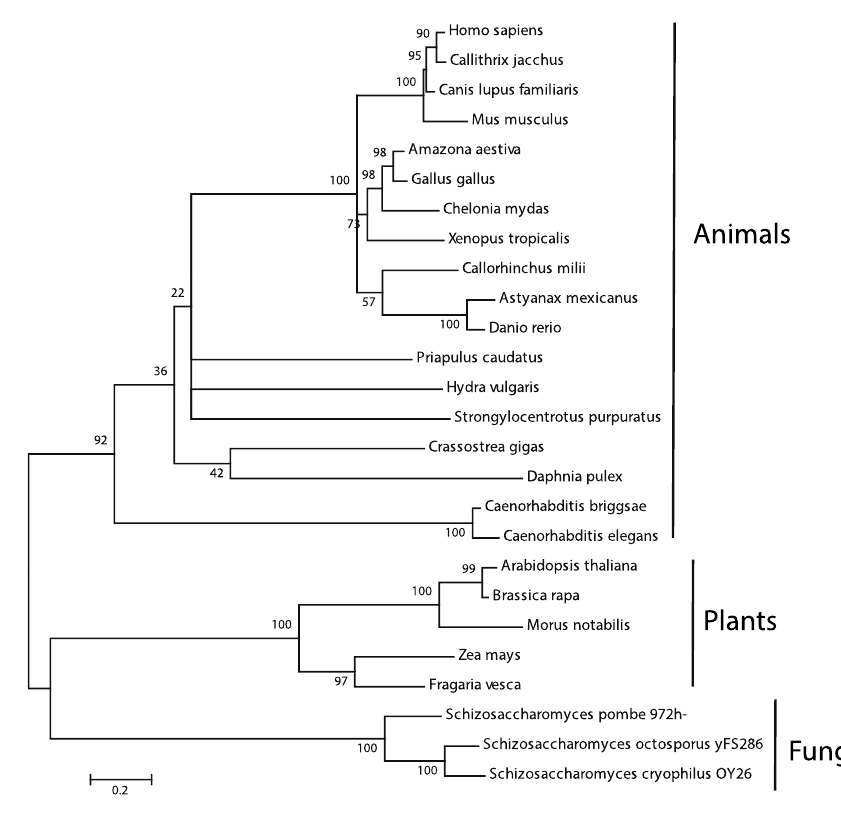
Figure 3. Phylogenetic reconstruction reveals clear orthology within each kingdom. Phylogenetic relationships between 26 BAG-1 homologs were determined using the Maximum Likelihood method based on the JTT matrix-based model, with complete deletion of amino acid positions containing gaps or incomplete datum. The tree with the highest log likelihood ( − 6107.0776) is shown. Bootstrap values indicate the percentage of 1000 replicates in which the associated taxa clustered in the resulting tree. The tree is drawn to scale, with branch lengths measured in the number of substitutions per site. The accession numbers of the sequences used, and the species’ scientific and common names are shown in Supplementary Materials Table S1.